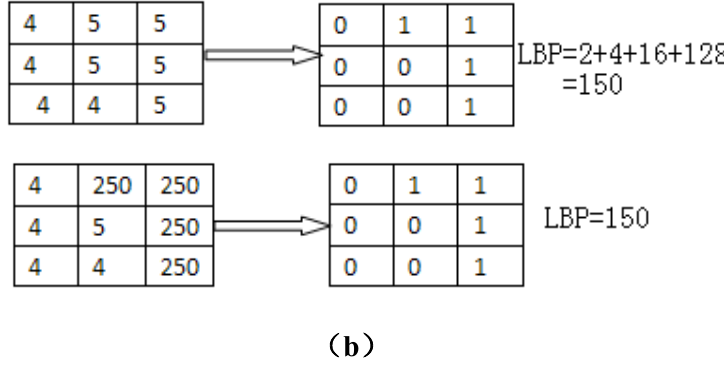
Figure 2. The incorrect instance of LBP